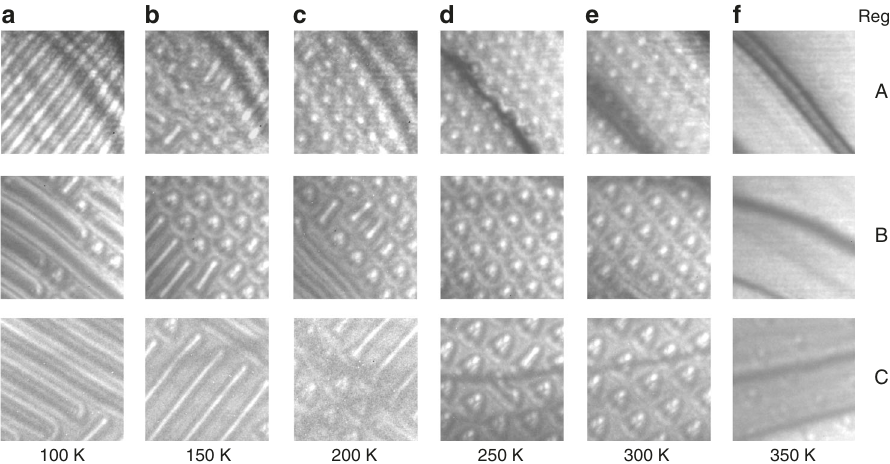
Fig. 3 LTEM images of the wedge-shaped lamella at different temperatures. The measurments are performed in the presence of a perpendicular magnetic fi eld of 0.16 T. a – f LTEM images recorded for three regions (A, B, and C) of the lamella shown as the white dashed boxes in Fig. 2a. The size of each image is 1 × 1 μ m 2